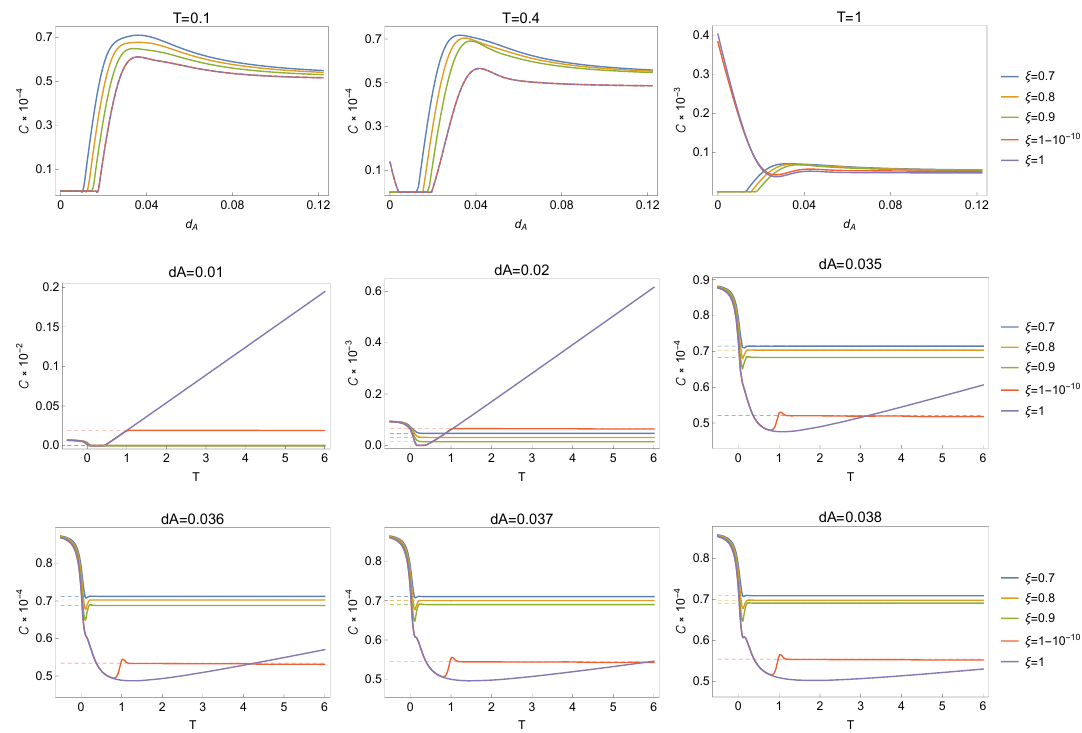
Figure 2 . E(cid:11)ect of the parameter (cid:24) . The parameter (cid:24) represents the asymptotic speed of the mirror moving to the left at late times. For (cid:24) = 1, the mirror is asymptotically null and an \horizon" appears at v = 0. In the (cid:12)gures here, we investigate the e(cid:11)ect of increasing (cid:24) on the concurrence between two UDW detectors. Top: plots of concurrence against d A at times T = 0 : 1 ; 0 : 4 ; 1. The results at T = 0 : 1 are similar to that obtained previously in [35], namely at small d A , there is an entanglement death zone with zero concurrence, while the concurrence increases to some peak before asymptoting to some constant value at large d A . However, we note that the death zone is present even for the (cid:24) < 1 mirrors, indicating that it is not a feature unique to mirrors with horizons. At a later time T = 0 : 4, we see a revival of the concurrence near the mirror when (cid:24) is close to 1. Indeed, at T = 1, we see that the death zone disappears completely for the (cid:24) = 1 mirror. Middle/Bottom: plots of concurrence against T for various d A . Note that the curves for (cid:24) = 0 : 7 ; 0 : 8 ; 0 : 9 on the middle leftmost plot overlaps on the T -axis, corresponding to the fact that d A = 0 : 01 lies within the entanglement death zone for these mirrors. The parameters used here are p (cid:20) = 48 (cid:25) , (cid:17) = 23, (cid:10) = 50 and (cid:1) x = 0 : 05. for (cid:24) = 1. However, the death zone is not unique to this BHC mirror. For example,